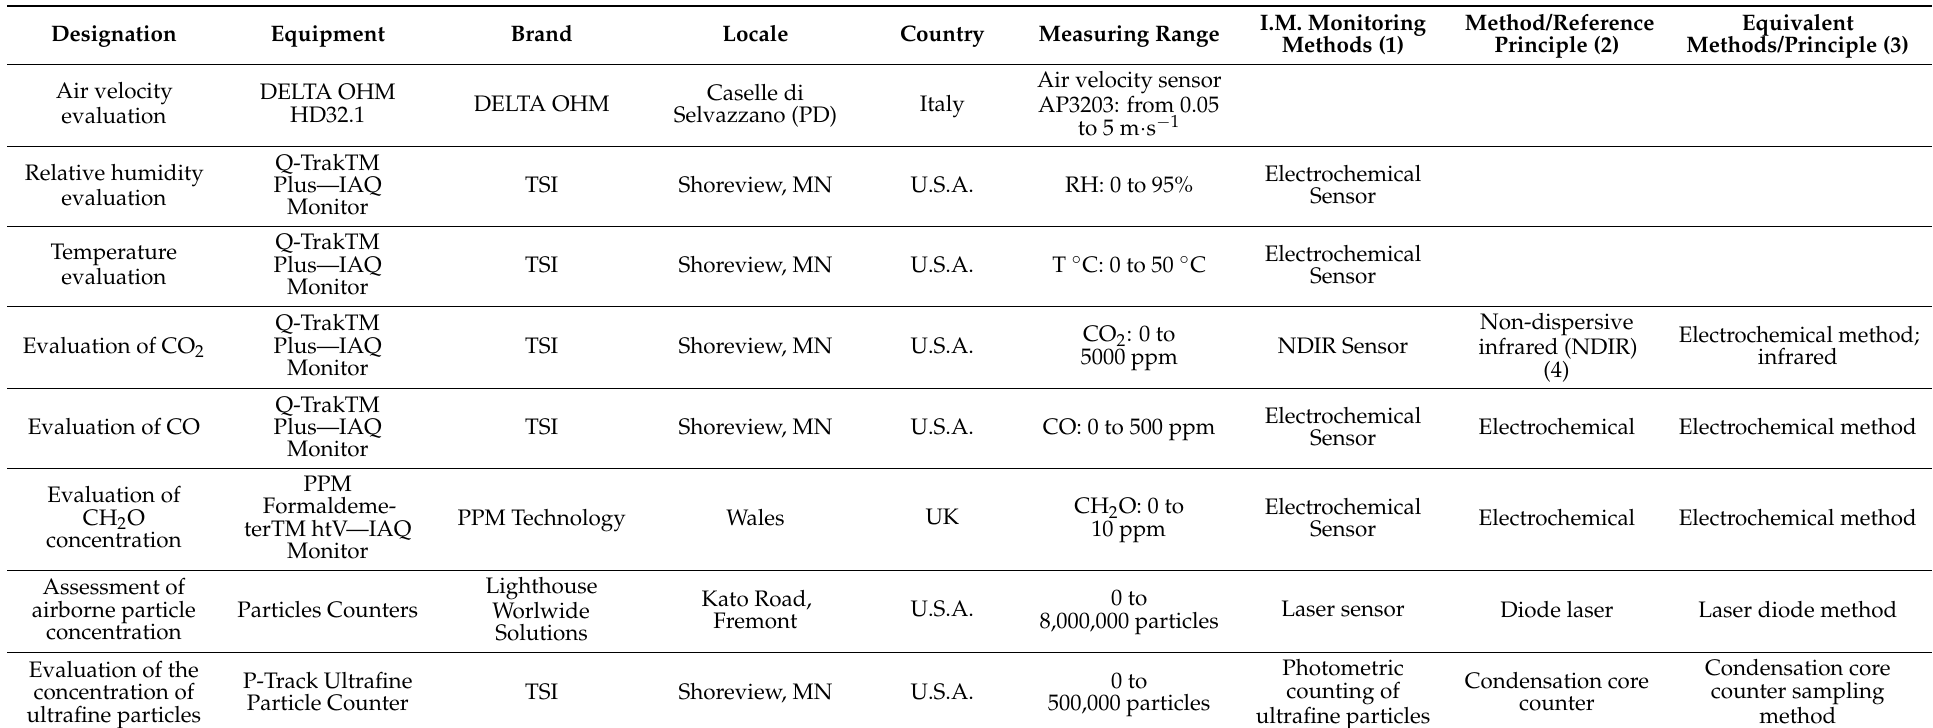
Table 1. Measured parameters, equipment and monitoring